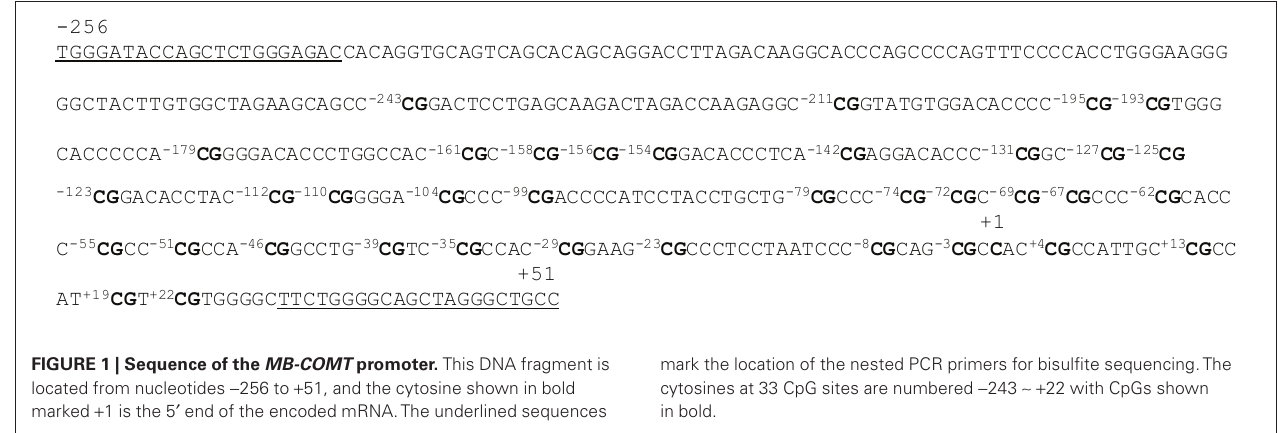
FiGure 1 | Sequence of the MB-COMT promoter. This DNA fragment is located from nucleotides − 256 to + 51, and the cytosine shown in bold marked + 1 is the 5 ′ end of the encoded mRNA. The underlined sequences